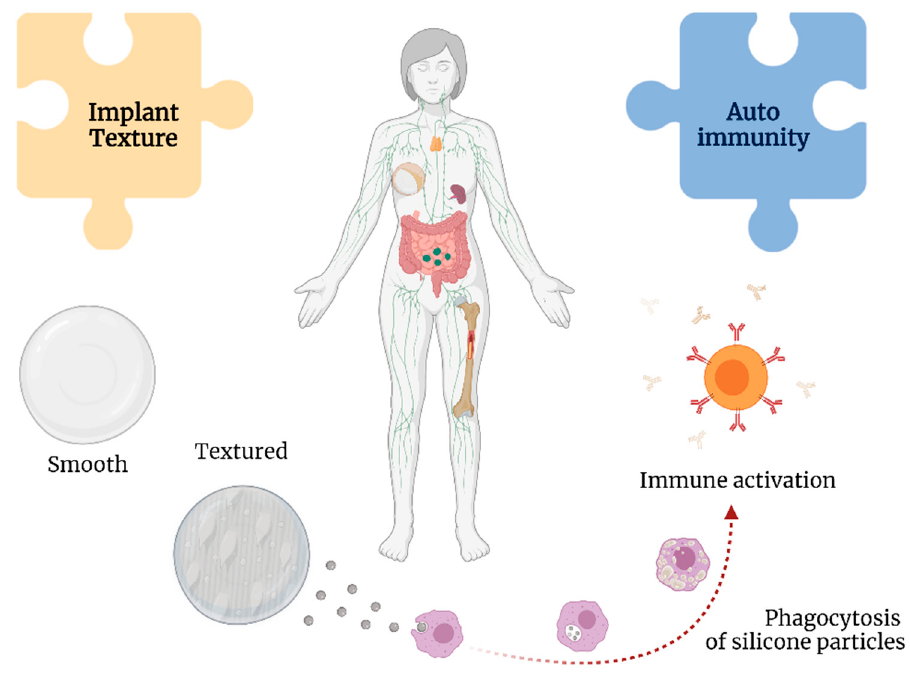
Figure 5. Associations between implant texture and autoimmunity with breast implant illness.